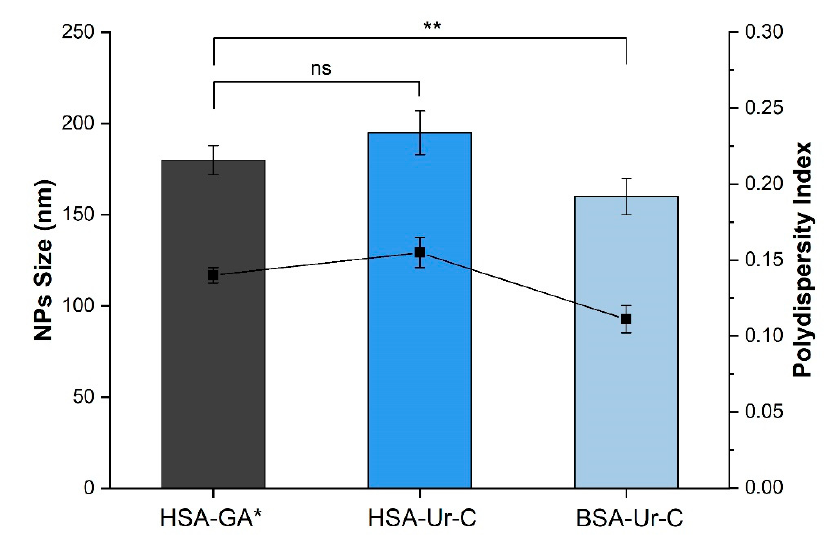
Figure 3. E ff ects of the type of serum albumin and cross-linking agent on the size and polydispersity index of NPs (the size values are depicted as columns, and the polydispersity index is shown as the solid line). * Albumin nanoparticles with glutaraldehyde (HSA-GA) were prepared according to the procedure described in [34]. Data are presented as mean ± SD ( n = 3), ** p < 0.001; ns = no significant.